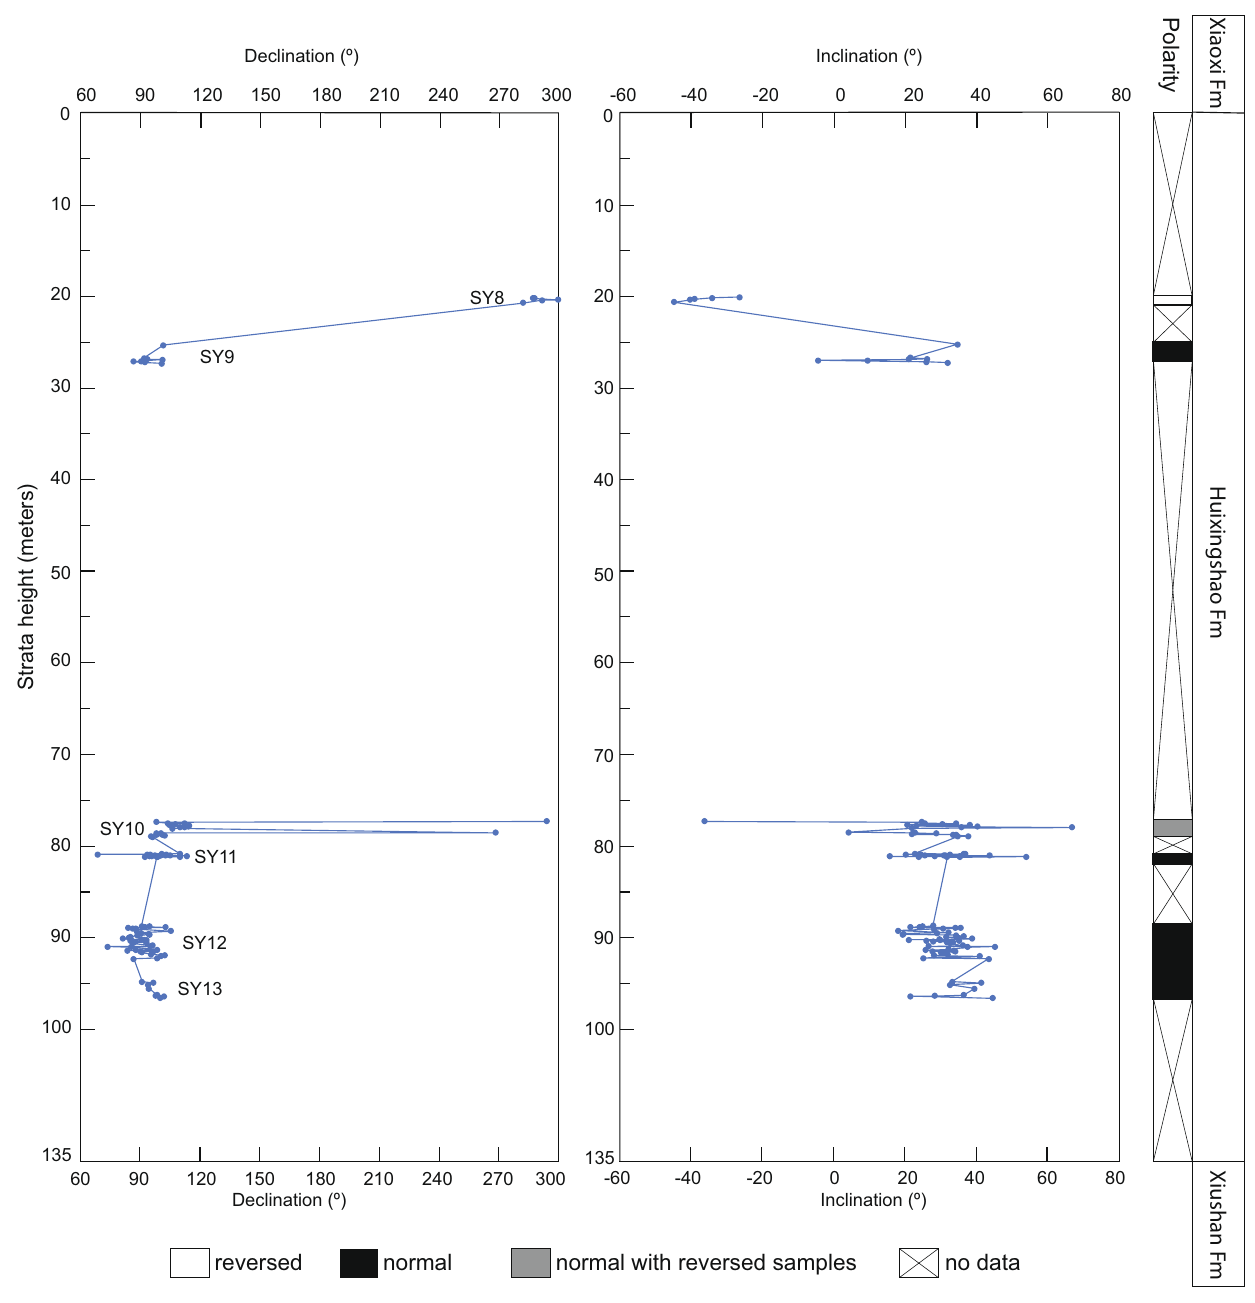
Fig. 2 | Magnetostratigraphy of the Huishingxiao Formation. Sampled section at Yongdong (SY). Directions with declinations >240° were interpreted as reversed polarity, and otherwise, as normal